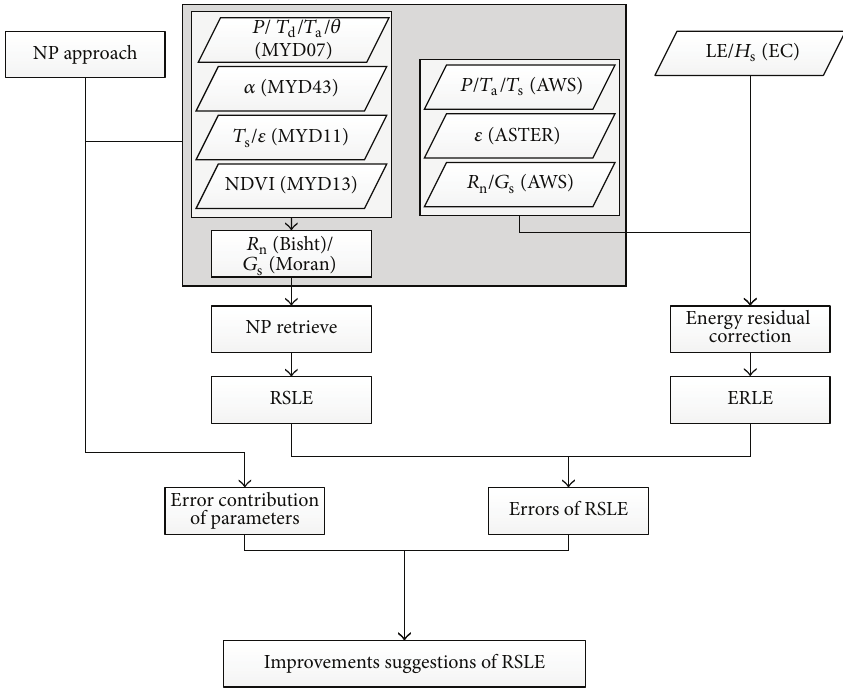
Figure 2: Schematic representation of the procedure for analysis in our